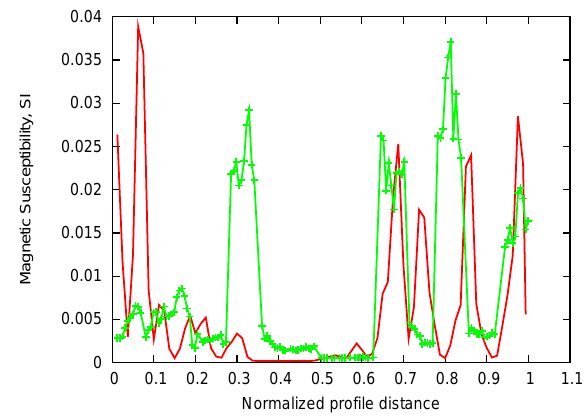
Fig. 1. Illustrative plot of observed magnetic susceptibilities (sym- bols) at an outcrop and the best fitting multiplicative cascade model. Note that only the amplitude and peak shapes are relevant; the location of the peaks along the distance axis is arbitrary.